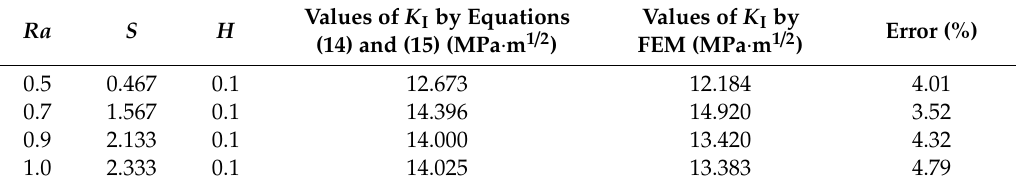
Table 4. Comparison results of the stress intensity factor (SIF) at crack tip B.